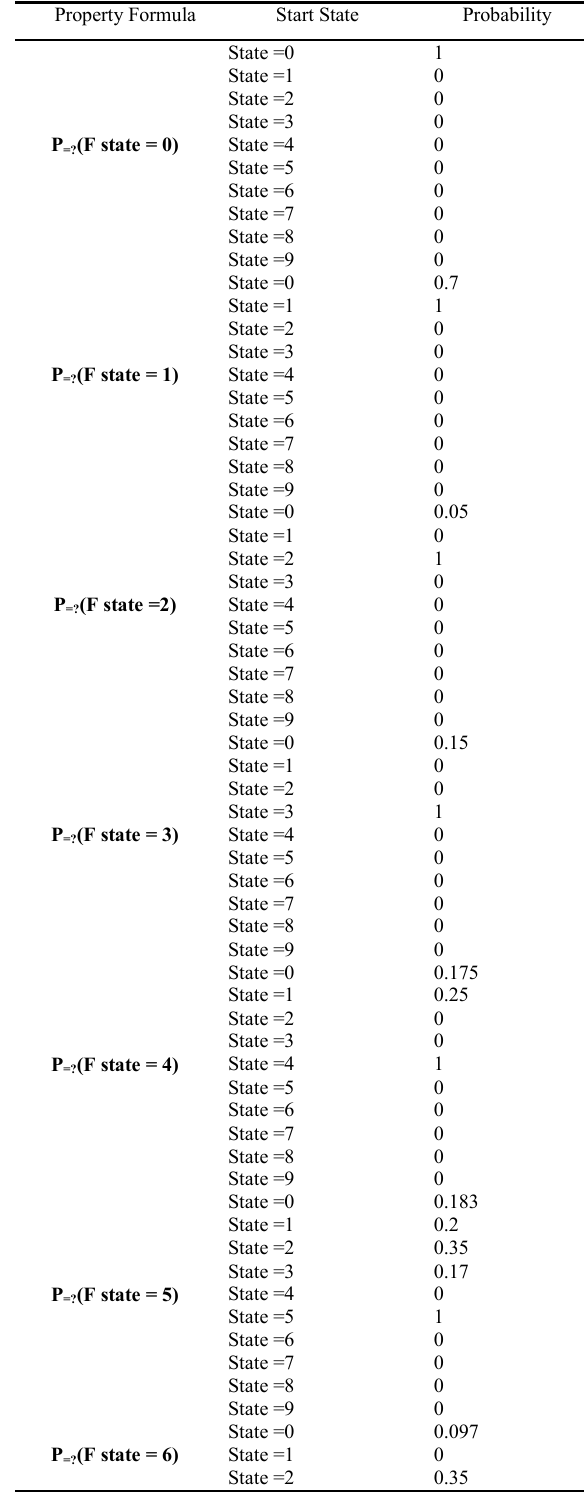
Table 3. Prism code Table 4. Probabilistic model checking